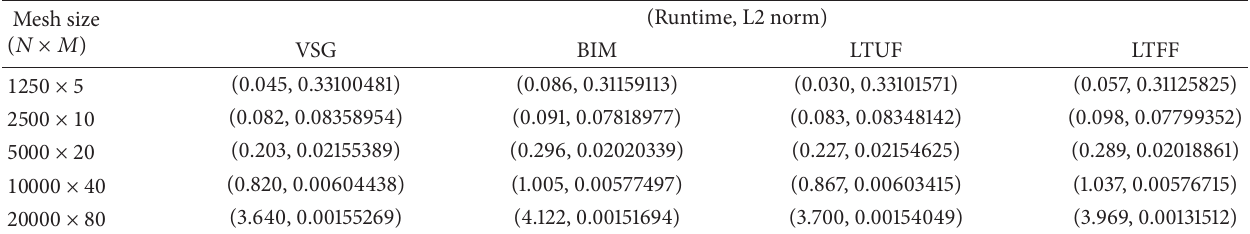
Table 3: Comparison of L2 norm and runtime in the solution.